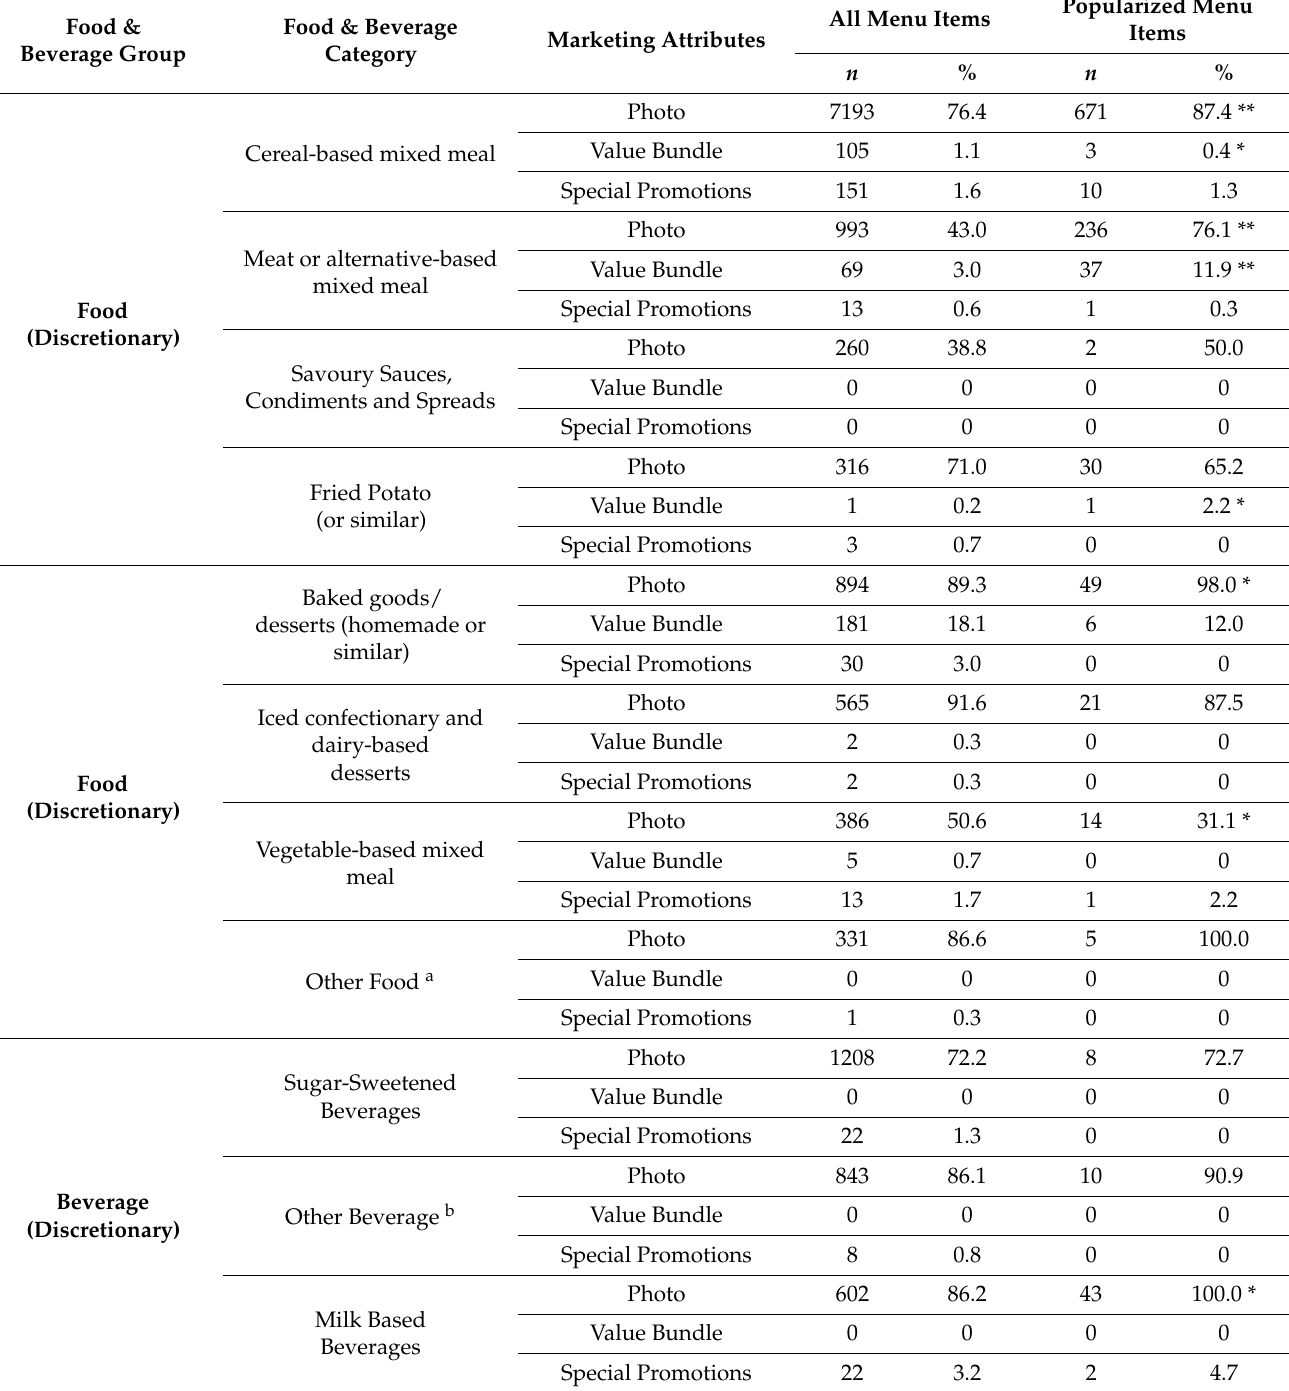
Table 4. Prevalence of photos, value bundles and special promotions for all menu items ( N = 25,877) and popularized menu items ( n = 1571) of 354 independent and franchise restaurants and takeaway outlets 1 . All menu items include popularized menu items and remaining regular menu